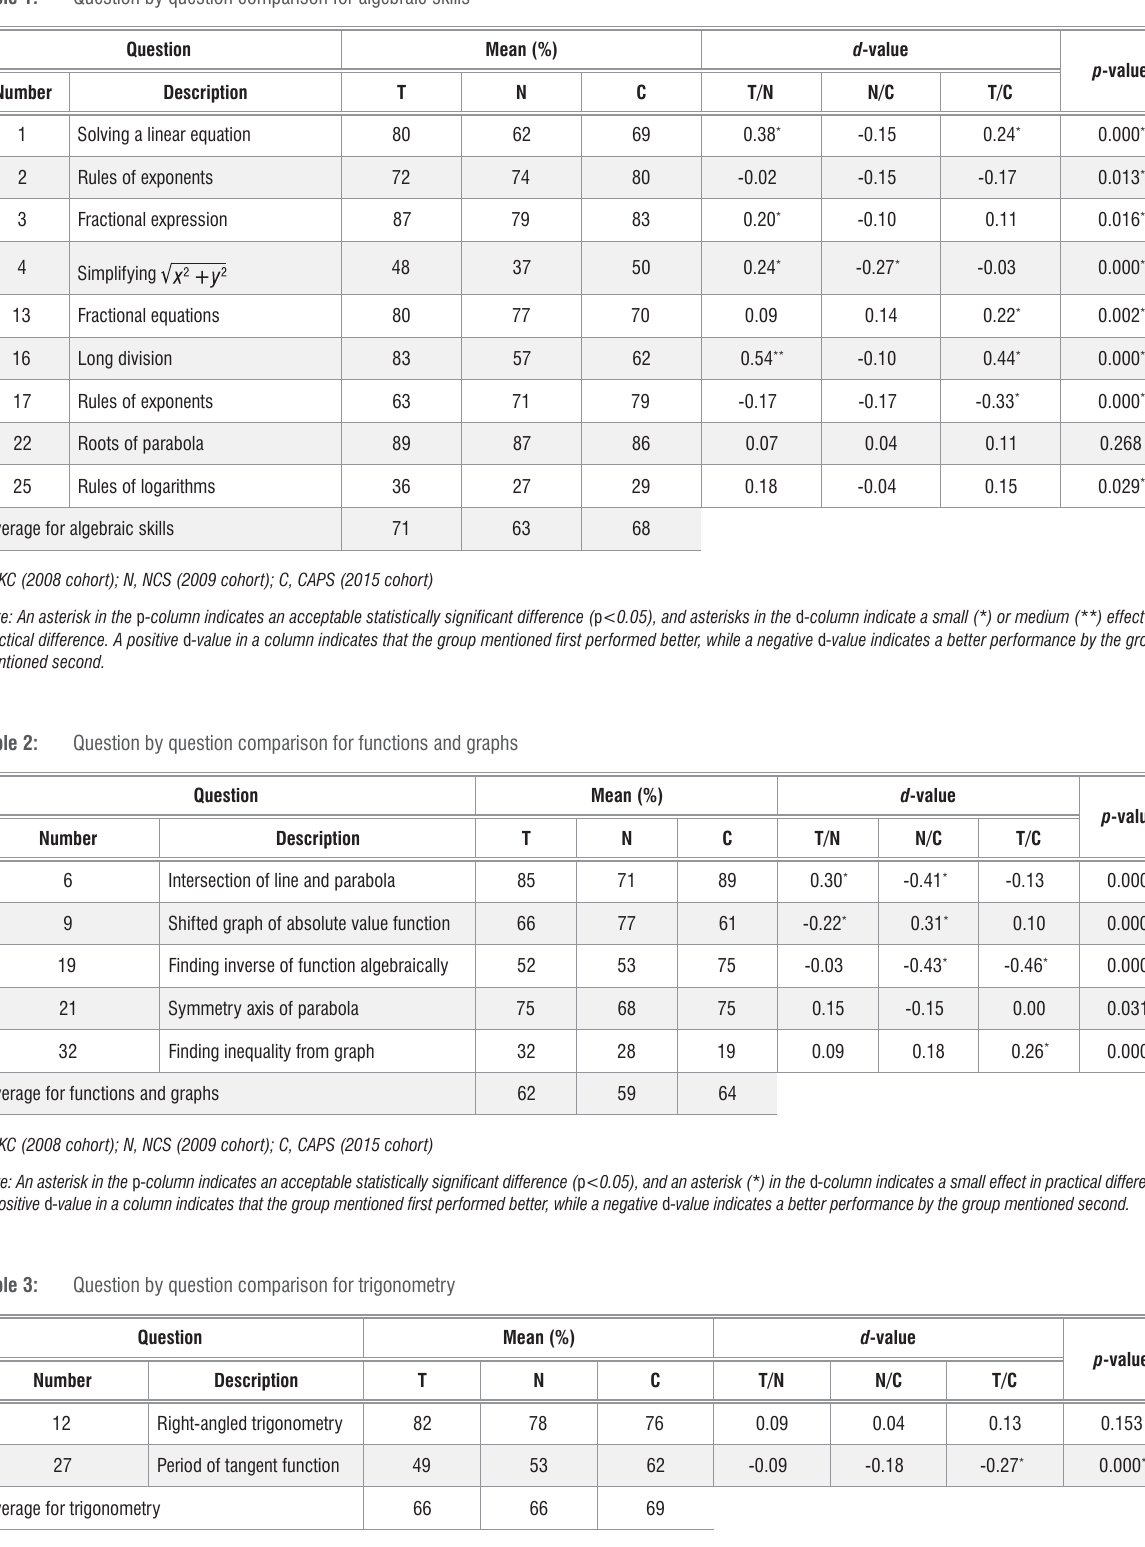
Question by question comparison for algebraic skills